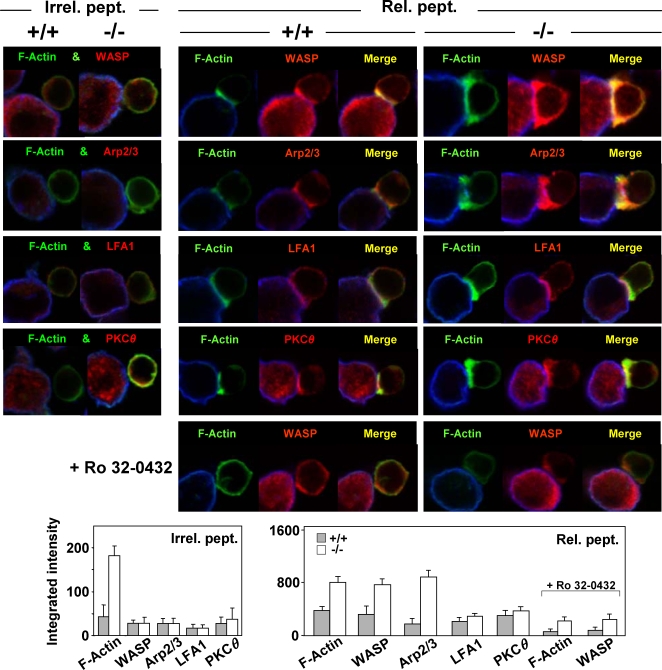
Ag-induced Accumulation of the Arp2/3/WASp Machinery at the APC Interface of Coronin-1A-deficient T Cells.Confocal analyses were performed as described in Figure 3 using purified CD8+ T cells from P14 TCR tg (+/+) and Coro-1A−/−×P14 TCR tg (−/−) mice (contact time of 30 min). Fixed cells were incubated with anti-LFA-1 (non-permeabilized cells) or anti-WASP, -p34-Arc/ARPC2 (Arp2/3 complex subunit), or -PKCθ (permeabilized cells) Abs, then with secondary, biotinylated Abs and streptavidin A546 (red). Phalloidin A-488 (green) labeling of F-actin was then performed. F-actin and WASP accumulation were also examined in the presence of the pan-PKC inhibitor Ro 32-0432. Statistical analysis of factor polarization to the T-cell/APC contact zone (bottom graphs) was performed based on computer-assisted quantification of integrated intensities [Area×Mean Fluorescence Intensity/µm2]. Values are from three experiments (≥50 conjugates were scored in each experiment).